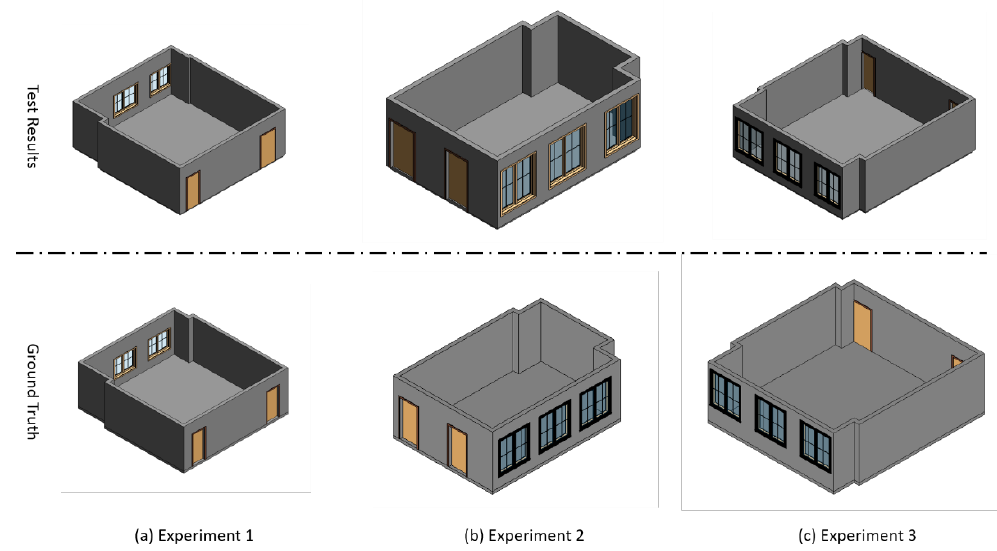
Figure 15. The compare of BIM format 3D models between the proposed method and ground truth.